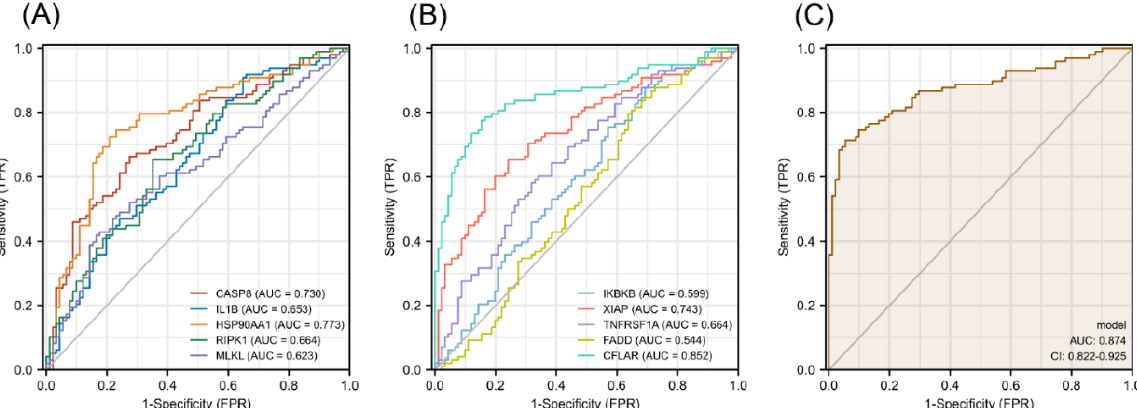
Figure 10. Diagnostic efficacy of necroptosis-related hub genes for COPD in the external dataset GSE57148. ( A , B ) ROC curves estimating the diagnostic performance of each characteristic gene. ( C ) ROC curve analysis by combining the expression levels of 7 validated necroptosis-related hub genes.